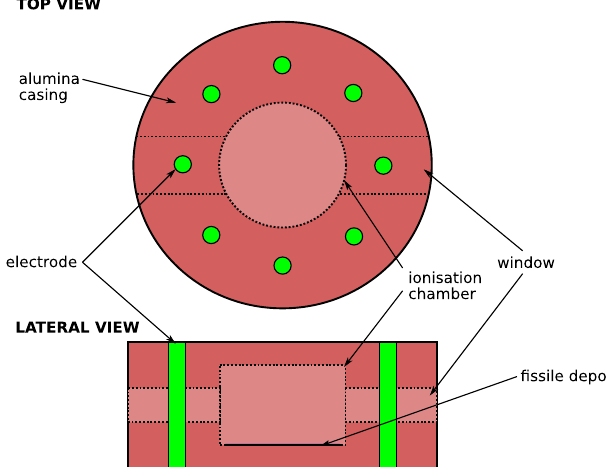
Fig. 14. Top and lateral cross sections of a micro-pocket fis- sion detector. Only two of the 8 electrodes are exposed to the ionization